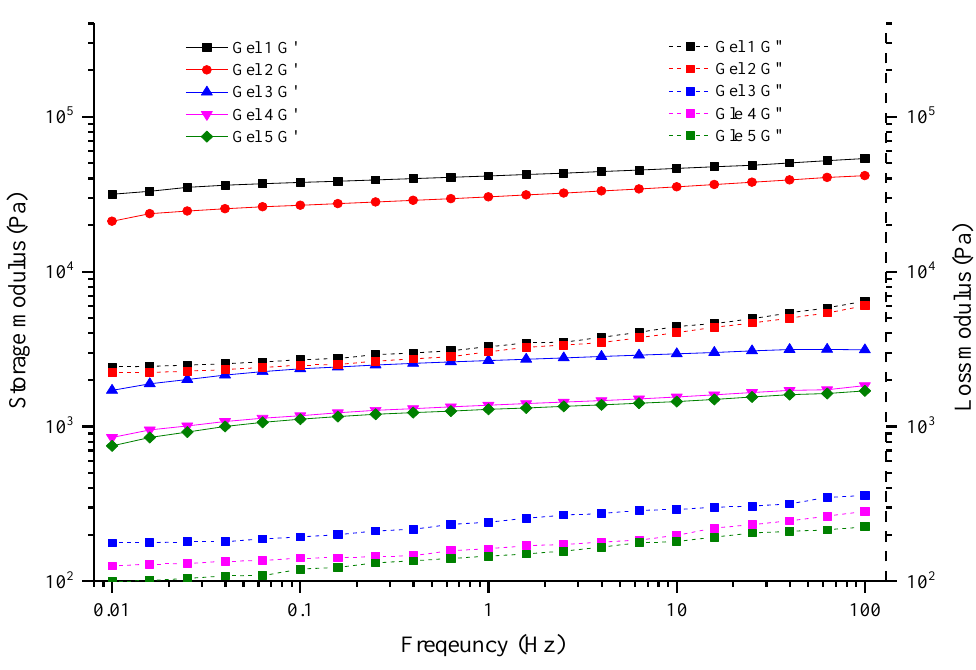
Figure 7. Dynamic frequency sweep of hydrogels.